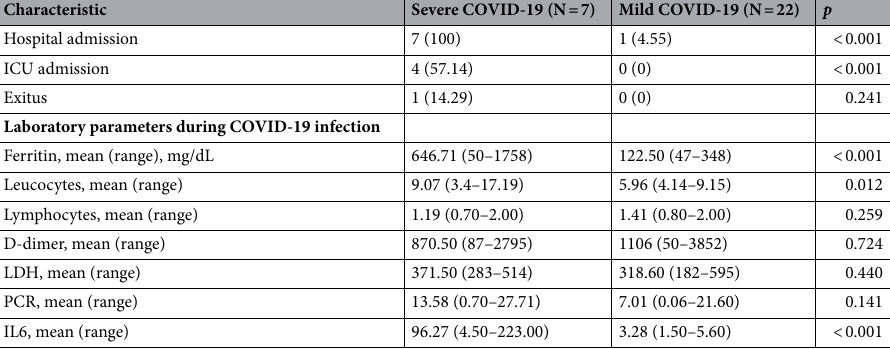
Longitudinal serial testing of patients with RT-PCR confirmed COVID-19 (n = 28) showed a reduction in the antibody titers (Fig. 3A). Seven patients had not presence SARS-CoV-2 IgG positivity at week 6 and four lost their positivity at week 24. The patients who lost the positivity for SARS-CoV-2 IgG titers were patients receiving immunosuppressive therapy (50% with MMF). This reduction was more pronounced in patients with mild COVID-19 disease (Fig. 3B). Clinically, they had more articular and hematological manifestations (75% of them). Immunologically, no significantly changes were found in T cells, B cells or plasma cells / plasmablasts. Cellular immune response to SARS‑Cov‑2 in COVID‑19 convalescent lupus patients. PBMCs from COVID-19 convalescent patients at week 12 were analyzed by flow cytometry (n = 6 severe, n = 14 mild) and compared with unexposed lupus patients. Characterization of the B cell response showed no changes in CD19 + B cells with a decreased percentage of CD19 + CD27-IgD + naive B cells (47.6% vs 78.9%, p < 0.001), an increased frequency of CD19 + CD27 + IgD- memory B cells (28.1% vs. 20.2%, p = 0.043) and CD19 + CD38 + CD27 + plasma cells / plasmablasts (46.4% vs. 19.8%, p < 0.001) (Fig. 3C and Figure S4). The increment was higher in patients with higher IgG antibody titers (53.7% vs. 35.0%, p = 0.008). There were no differences according to disease severity (Fig. 3D). There was also a disrupted T cell homeostasis with reduced CD8 + T cell percentage (26.9% vs 40.6%, p < 0.001, Fig. 3E and Figure S4), especially of naïve CD8 + T cells (32.24% vs. 48.21%, p = 0.013) compared to unexposed patients. Increased memory CD8 + T cells were noted (28.09% vs. 17.28%, p = 0.0037, Fig. 3E), more pronounced in severe disease (Figure S5). No differences were observed in total, memory, naïve, effector and terminal dif- ferentiated effector memory (TEMRA) CD4 + T cells, NK cells or cell activation (Figure S6). Among CD4 + T cells, there was a predominant Th2 and Th17 response with increased gene expression of GATA3 and RORG transcrip- tion factors, more prominent in severe COVID-19 and SARS-CoV-2 antibody-producing patients (Fig. 3F). Measurement of proinflammatory cytokines showed only increased IL4 and IFNG expression levels. There were no changes in IFN-induced genes (Fig. 3G and Figure S7). Longitudinal immune dynamics of COVID‑19 convalescent patients. Twelve convalescent patients’ cellular immune responses were studied longitudinally (Table S6). A transient increase in the percent- age of plasma cells / plasmablasts and a reduction of naïve B cells (83.3 vs 33.9%, p < 0.001) were apparent at 12 weeks ( p < 0.001) reverting by week 24. Meanwhile, memory B cells showed a progressive increase over time ( p = 0.01, Fig. 4A). These changes were more pronounced in antibody-producing vs non-antibody producing patients: for plasma cells / plasmablasts a difference in the increase of 13% at 12 week ( p < 0.001) and for memory B cells an increase of 12.0% and 16.0% at 12 and 24 week ( p = 0.006 and p < 0.001, respectively. Figure 4B). B cell response was not affected by disease severity (Figure S8). CD8 + T cell total numbers recovered progressively after week 6 ( p < 0.001) but no changes were observed in CD4 + T cells (Fig. 4C). There was a reduction of naïve and effector CD8 + T cells and a progressive sustained increase in memory and TEMRA CD8 + T cells during the study period, regardless of disease severity (Fig. 4D and Figure S9). Of the transcription factors tested, only RORG gene expression levels were significantly high at week 6, progressively reducing thereafter ( p = 0.001, Fig. 5A). Higher RORG expression was associated with poor out- come (persistent lung opacities (n = 2) and thrombosis (n = 3)) (Figure S10 and Table S7). GATA3 levels showed a mild increase by week 12 ( p = 0.022, Fig. 5A). All changes were more pronounced in antibody-producing vs non-producing patients: for RORG gene expression a decrease of 1.6 and 2.8 at 12 weeks and 24 weeks ( p < 0.001) and for GATA3 gene expression an increase of 0.5 at 12 week ( p = 0.005). In those with severe vs mild disease: for RORG gene expression an increase of 1.9 and 3.1 at 12 and 24 weeks ( p < 0.001) and for GATA3 gene expression a